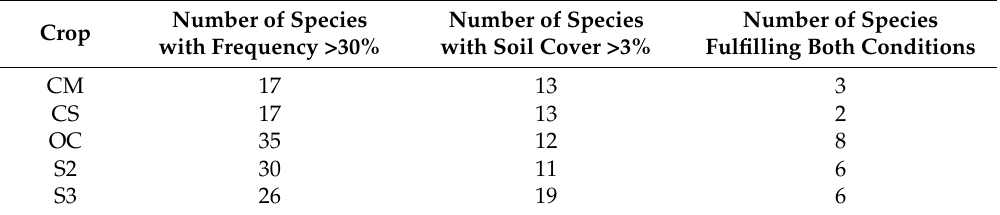
Table 4. Number of species with highest frequency and soil cover in the different crops in all four sampling years. CM: cereal monocrop, CS: cereal after sainfoin, OC: organic cereal, S2: sainfoin second